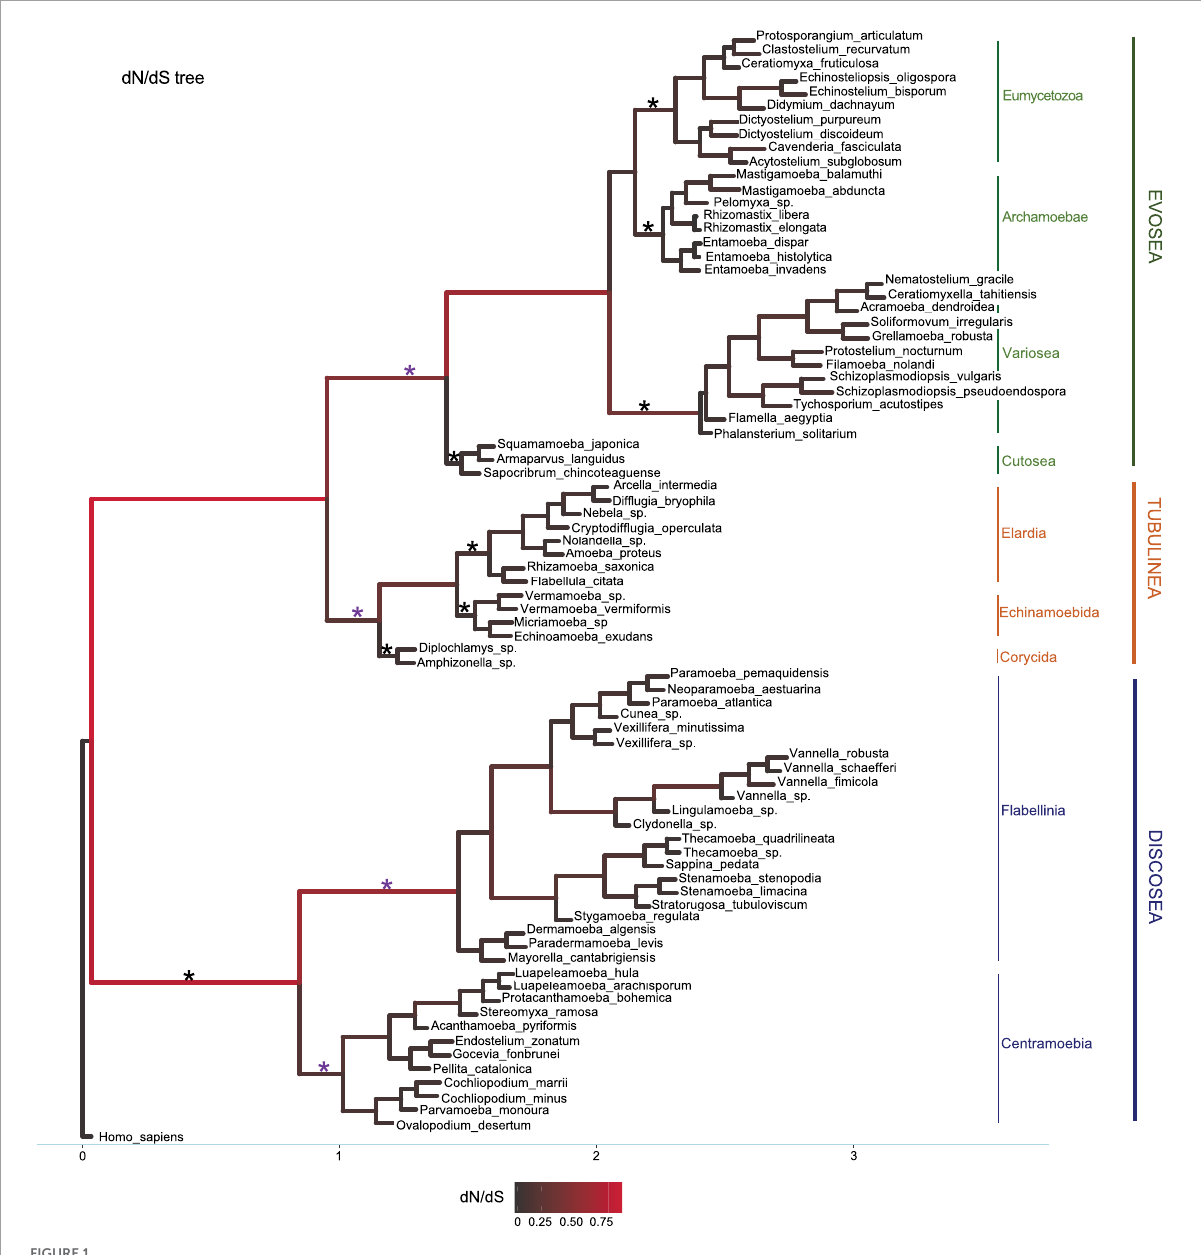
FIGURE1 Phylogeny used in the M1 model with dN/dS values as branch lengths for visualization. The dataset is from the concatenated 20 shared genes comprising 10,365 sites. Subclade names were marked accordingly. Branches were colored by dN/dS values. Branches tested in branch-site model were marked with star symbols and purple star represented detection of positive selected